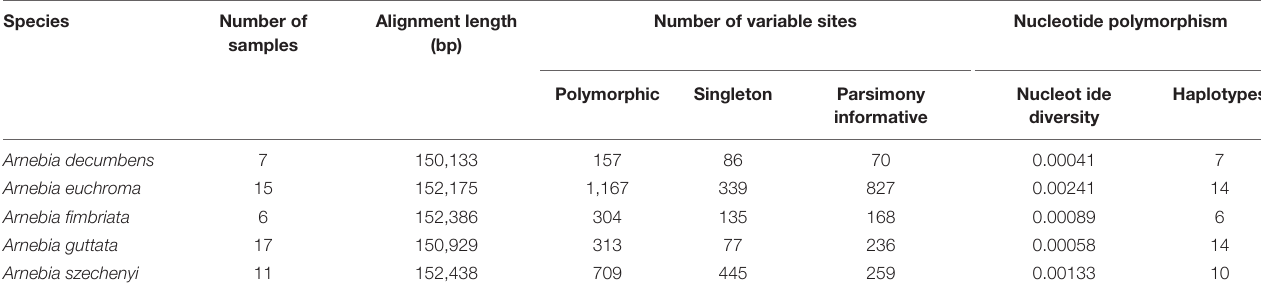
FIGURE 4 | Divergence times of Lithospermeae obtained from BEAST analysis based on all coding protein-coding genes with two priors. The mean divergence time of the nodes is shown next to the nodes, and the blue bars correspond to the 95% highest posterior density (HPD). TABLE 4 | Intraspecific chloroplast genome sequence divergence of five Arnebia